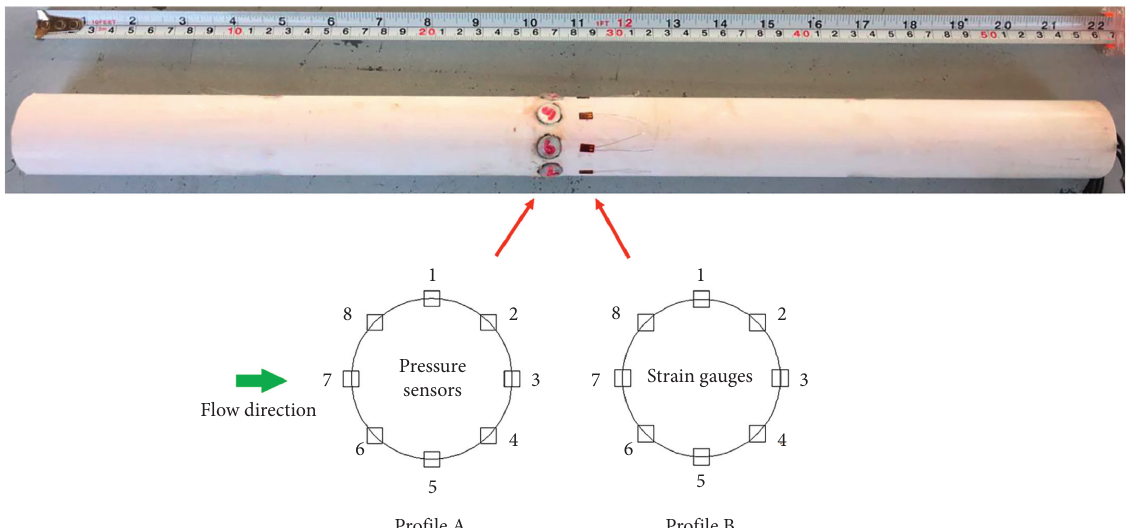
Figure 4: Schematic diagram of pipeline model sensor layout.